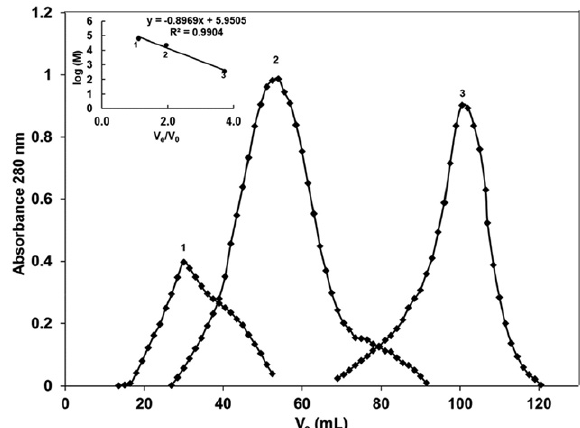
Figure 4. Gel permeation chromatography through Sephadex G-100 of standard proteins with known molecular weight: (1) BSA; (2) trypsin; (3) methylene blue.